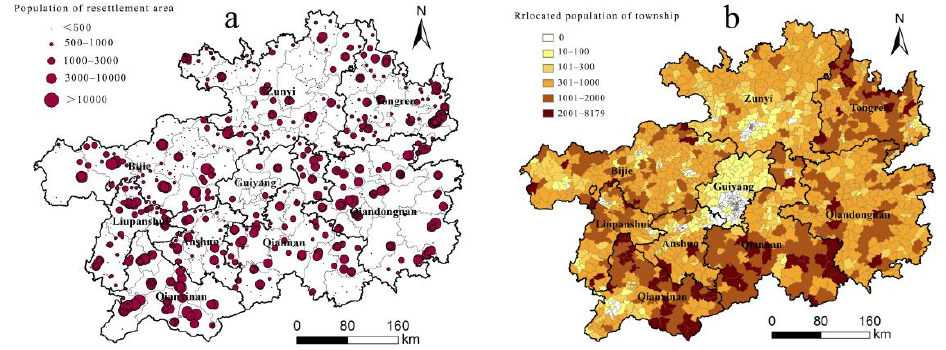
Figure 2. Distribution of PAR settlements 2016–2019 ( a ); spatial distribution of population moving out at township level 2016–2019 ( b ).